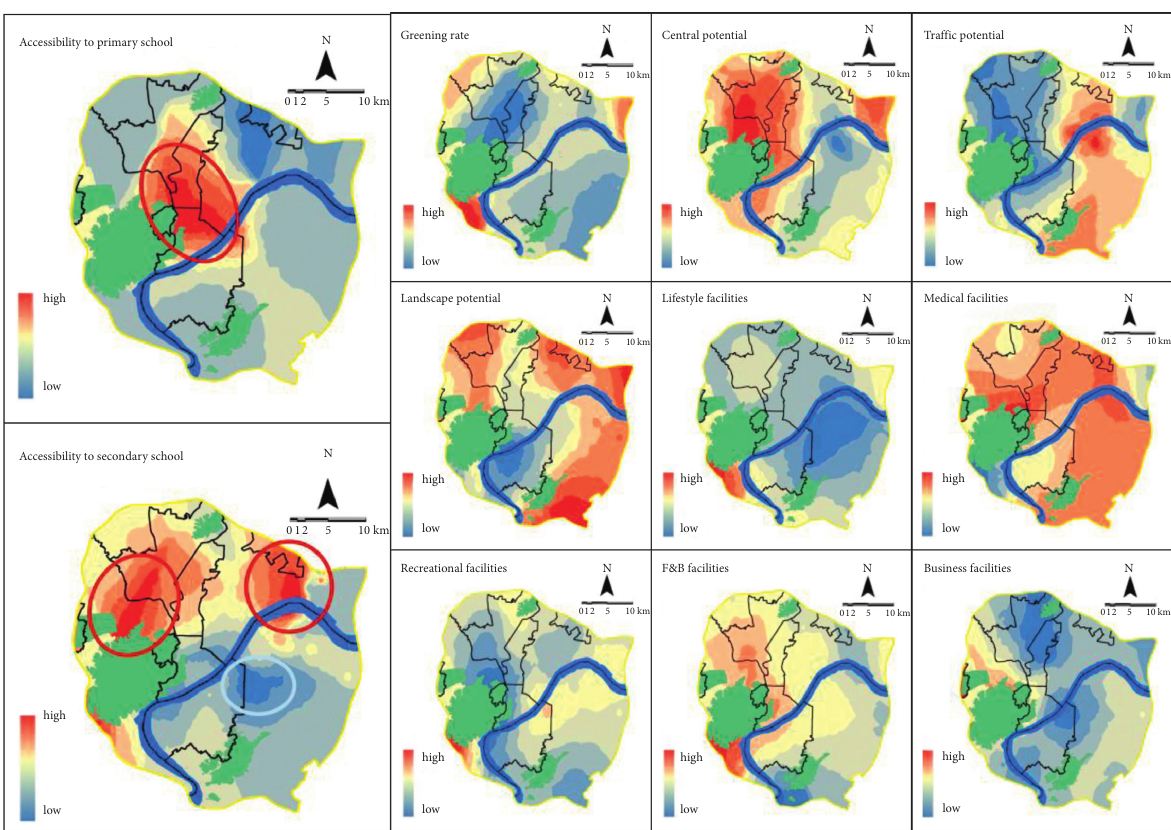
Figure 5: Spatial distribution of regression coefficient from the perspective of education accessibility based on the GWR